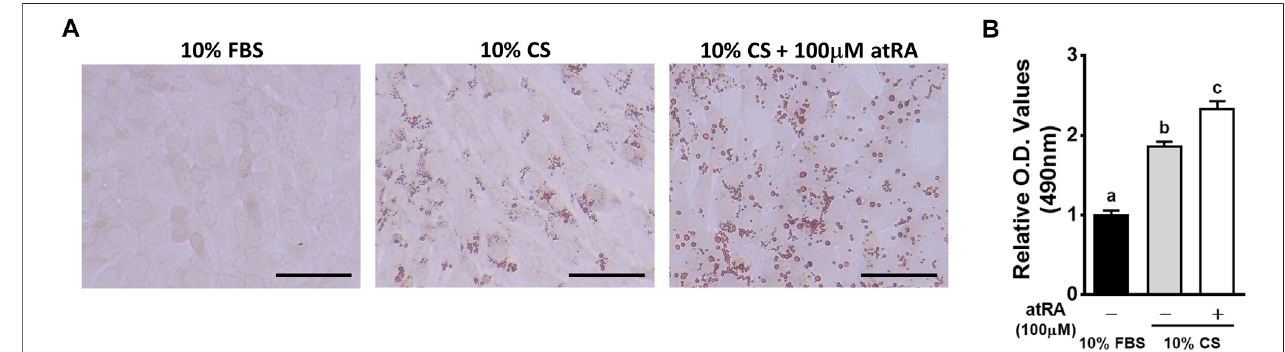
FIGURE 1 | Effects of various media on the lipid accumulation in QM7 cells. Oil-Red-O (ORO) staining (A) and O.D. values (B) . QM7 cells were incubated with differentmedia,10%fetalbovineserum (FBS),10%chickenserum(CS),oracombinationof10%CSand100 μ Mall- trans -retinoicacid(atRA) for48 h.Lipiddroplets in the cells were visualized under a microscope after ORO staining and quanti fi ed by a relative amount of ORO per cell which is normalized by a group of 10% FBS. Scale bar: 100 μ m. All data were shown as mean ± SEM ( n = 8 from 4 independent experiments). One-way ANOVA followed by Tukey ’ s multiple comparison test was used for statistical analysis by the GraphPad PRISM program and statements of signi fi cance noted by (A-C) are based on testing at p < 0.05.